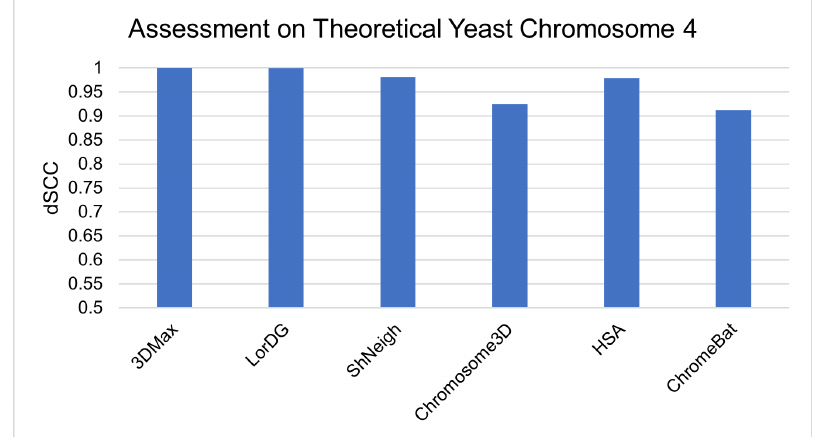
Figure 14. Comparative evaluation of methods on simulated yeast